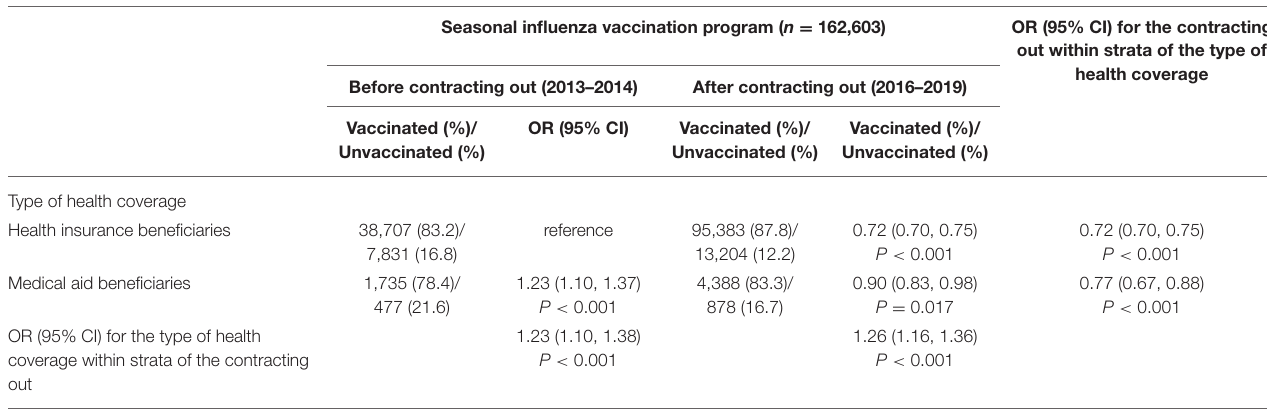
out within strata of the type of health coverage